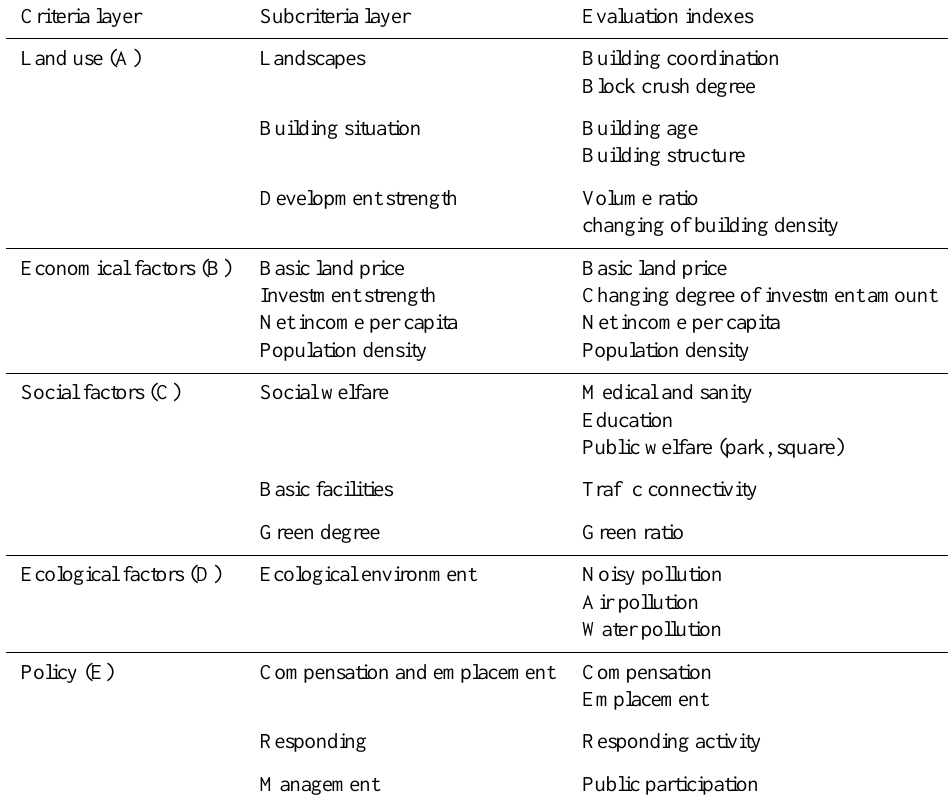
Table 4. The results from the rough set selection and the fuzzy measure